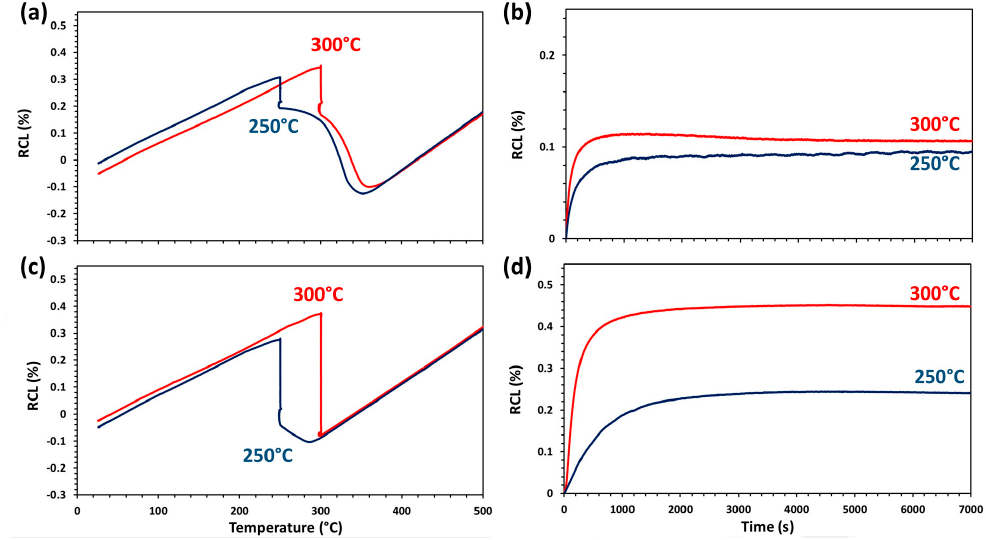
Figure 5. For the core steel (0.29 Cwt.%), relative change in length (RCL) curves as a function of Temperature and time for the different T iso -t iso ( a ) and ( b ) for T γ = 900 °C and ( c ) and ( d ) T γ = 830 °C. Table 5 collects microstructural characterization results based on XRD (V γ and C γ ), systematic manual point count (V α ) and dilatometry (V α’ ), by applying the Koistinen–Marburger (K-M) expression as described by Navarro-Lopez et al. [24]. At this point, it must be clarified that martensite formed for the core alloy by quenching from 900 and 830 °C decomposes from body-centered tetragonal (BCT) martensite to body-centered cubic (BCC) ferrite and orthorhombic cementite during isothermal annealing at 300 and 250 °C. Additionally, it has to be recalled that the sample quenched